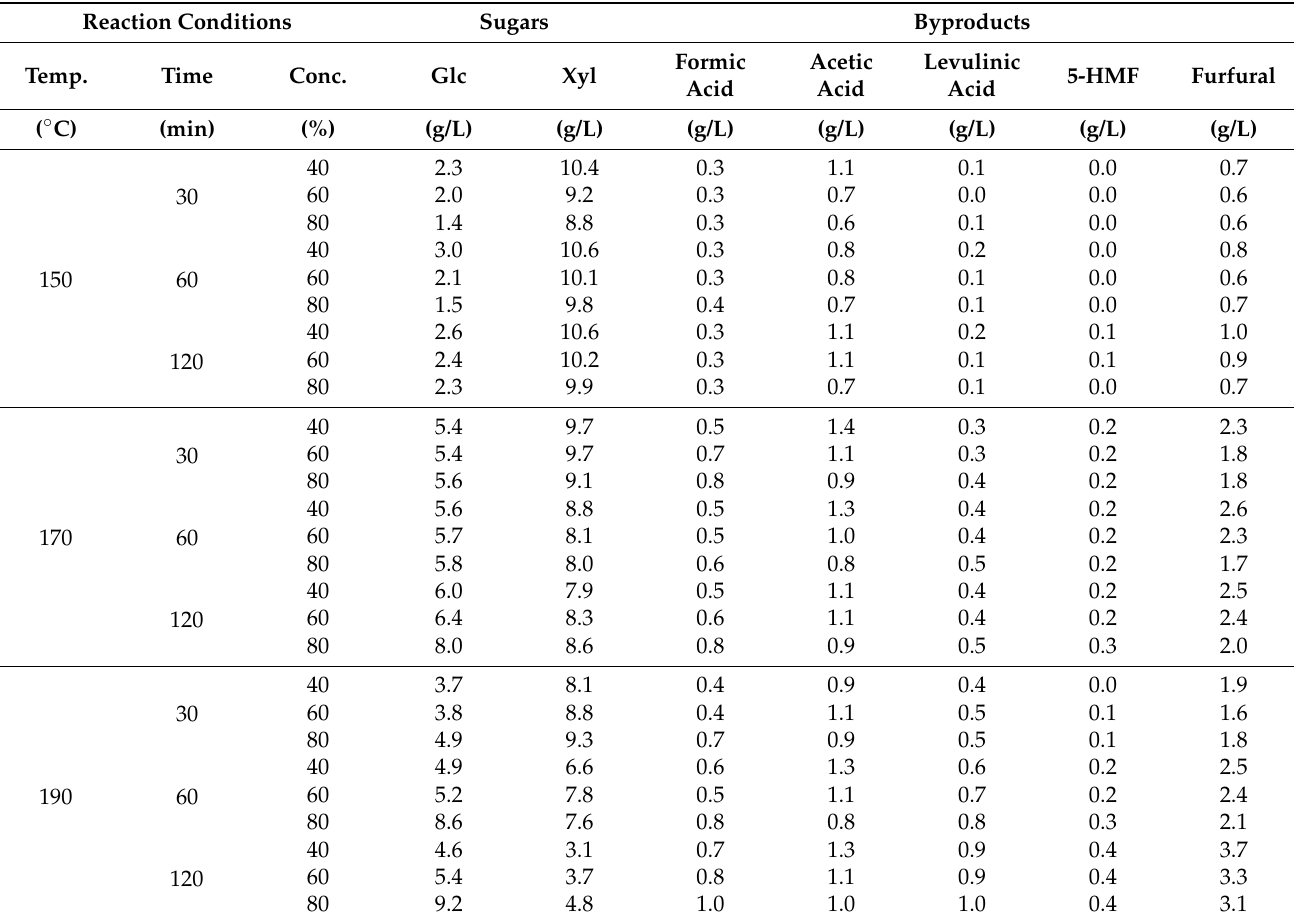
Table 3. Effects of reaction temperature, time, and ethanol concentration on sugar and byproduct concentrations in liquid hydrolysate. Reaction Conditions